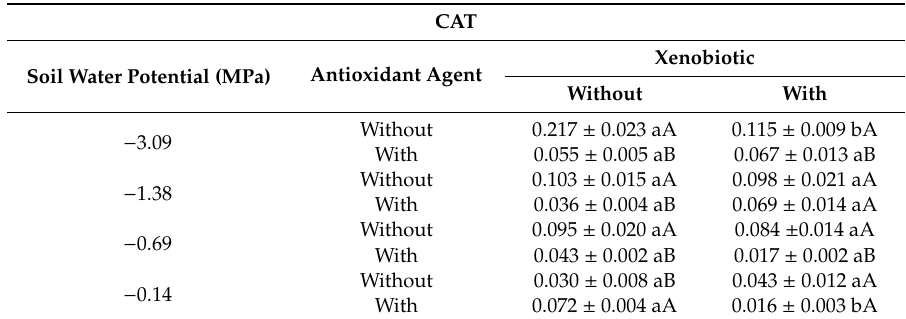
Table 11. Catalase (mmol mg protein − 1 min − 1 ) activity in soybean plants submitted to di ff erent soil water potentials and xenobiotic and antioxidant applications.